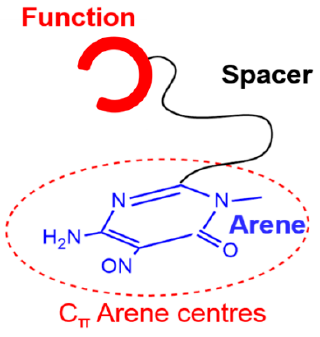
Figure 1. General structure of an Ar-S-F ligand.